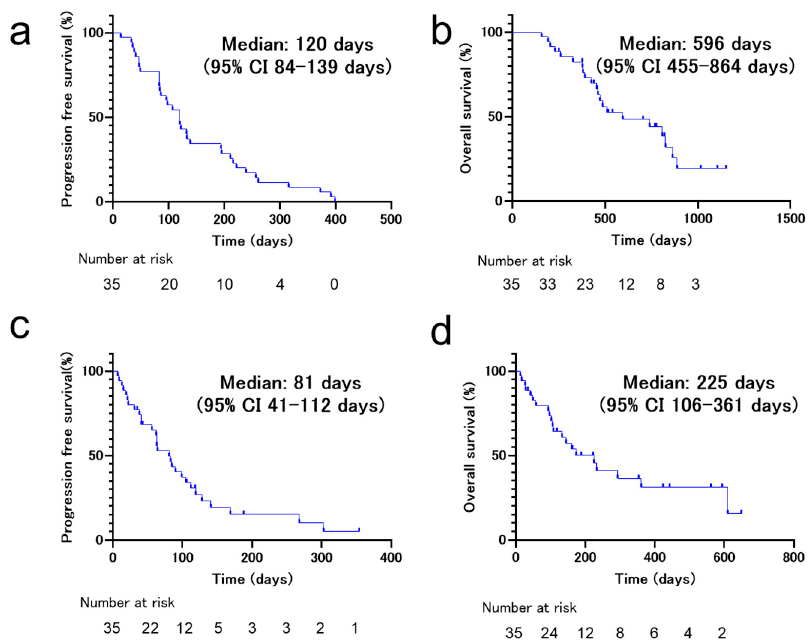
Figure 2. Kaplan–Meier survival curves of progression-free survival (PFS) and overall survival (OS) of patients who received immune checkpoint inhibitor (ICI) rechallenge treatment. ( a ) PFS of non-small cell lung cancer (NSCLC) patients ( n = 35) on first ICI treatment. ( b ) OS of NSCLC patients ( n = 35) on first ICI treatment. ( c ) PFS of NSCLC patients ( n = 35) on ICI rechallenge treatment. ( d ) OS of NSCLC patients ( n = 35) on ICI rechallenge treatment.